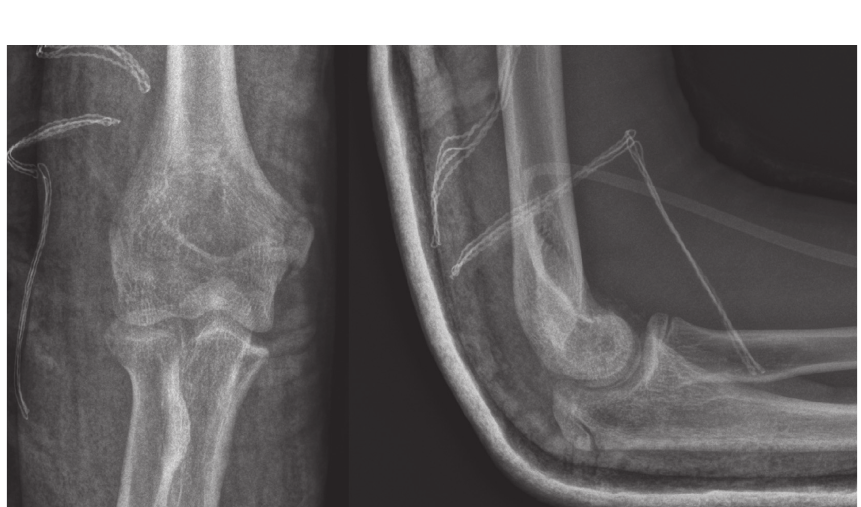
Figure 2: Patient number 4, postoperative X-rays. Osteochondral fragment reduced and fixated with 3 ×